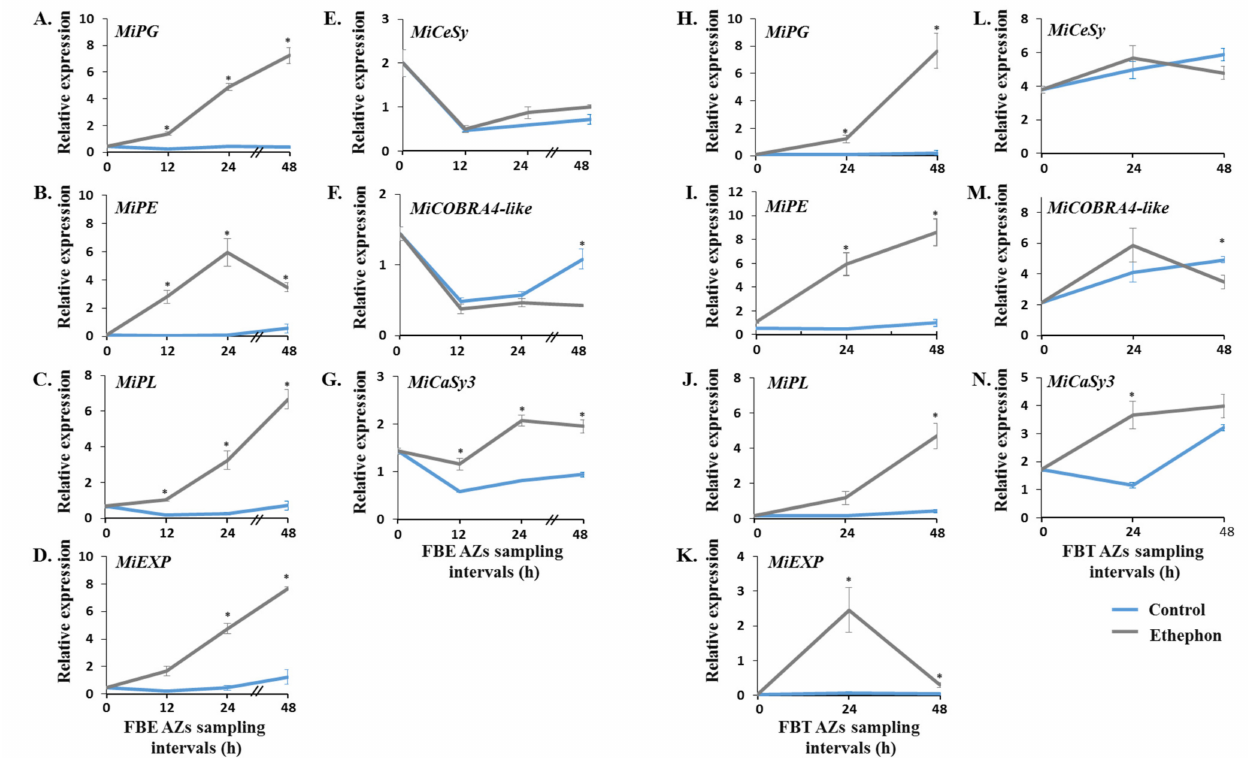
Figure 5. Effect of ethephon treatment on the expression profiles of seven genes encoding for distinct cell wall-modifying proteins in mango fruitlet AZs of FBE ( A – G ) and FBT ( H – N ) during 48 h. The analysis of qRT-PCR was performed using cDNA prepared from total RNA extracted from FBE or FBT AZs. Values represent relative expression levels normalized against the endogenous reference gene, MiGAPDH . For each group and time point, the data are presented as the means ± SE of three independent biological replicates, and two technical replicates. Asterisks (*) denote significant differences between ethephon-treated and control AZ samples at each sampling point ( p ≤